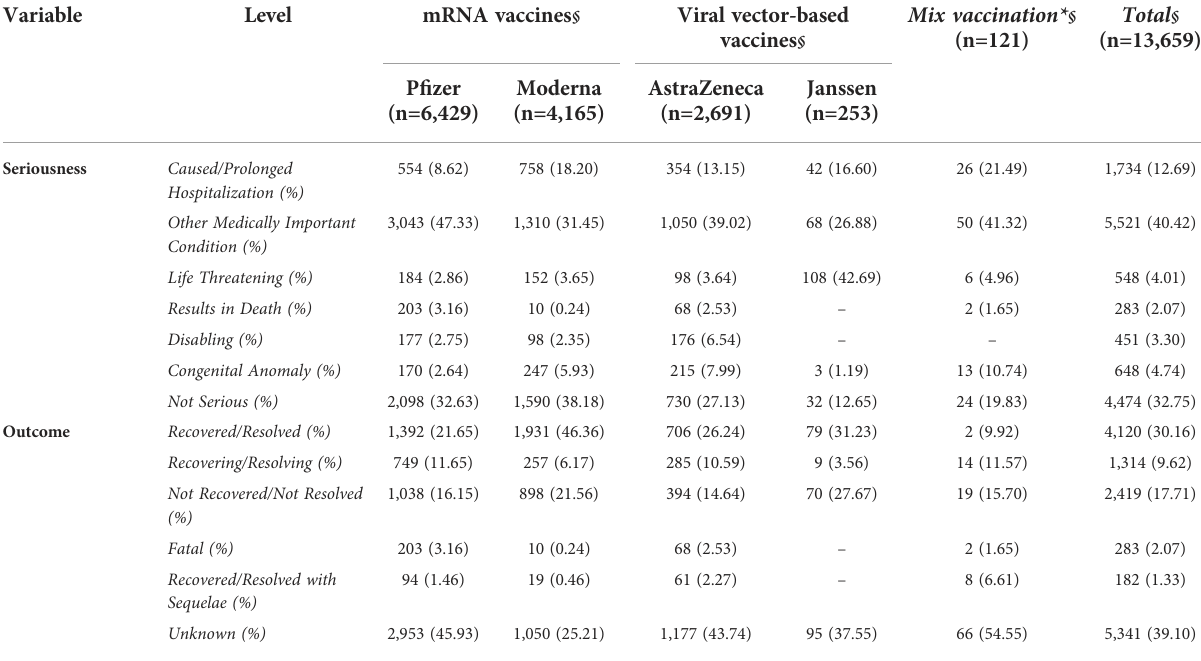
TABLE 3 Seriousness and outcome of AEFI related to maternal exposure during pregnancy to COVID-19 vaccines reported in EudraVigilance from 1 January 2021 to 31 December 2021.